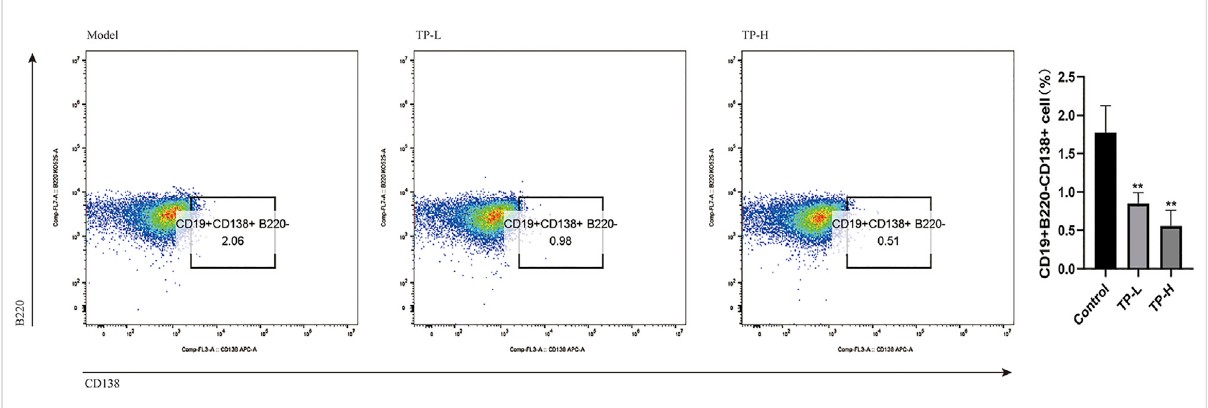
SpleenplasmacellratioinMRL/lprmice. Comparedwiththemodelgroup, theproportionsofCD19 + CD138 + B220 − plasmacellsintheTP-Land TP-H groups were signi fi cantly decreased ( p <